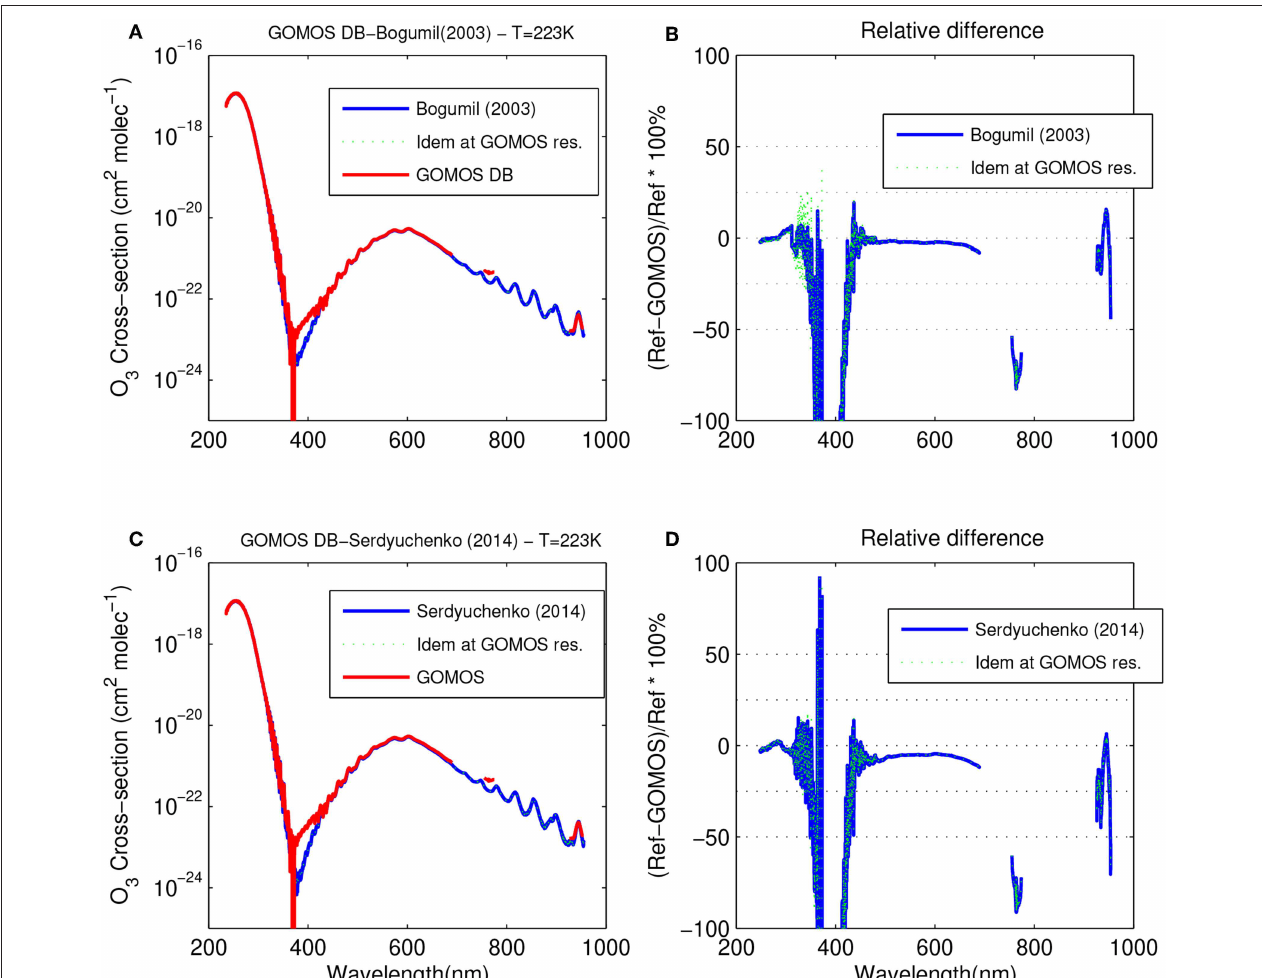
FIGURE 1 | Comparison of the O 3 GOMOS DB spectra with spectra from (A) Bogumil03, and (C) Serdyuchenko14, at a temperature of 223 K. (B,D) show the corresponding relative differences. GOMOS DB spectra have been linearly interpolated in temperature, and in the case of (B,D) , at the wavelength of the reference